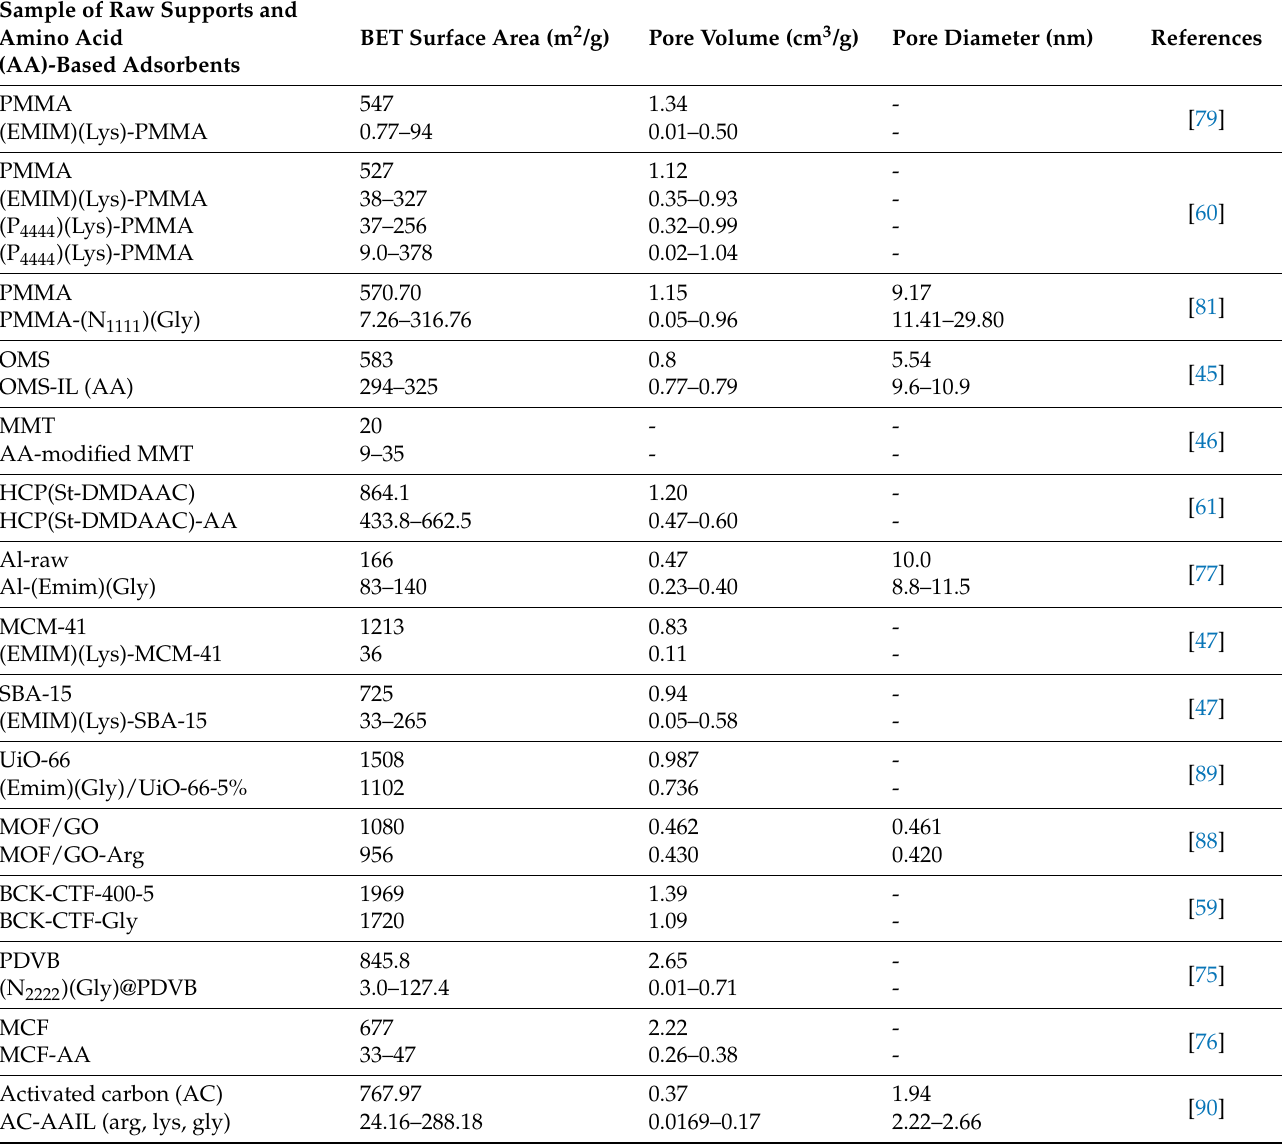
Table 6. Surface area, pore volume, and diameter of raw supports and amino acid-based